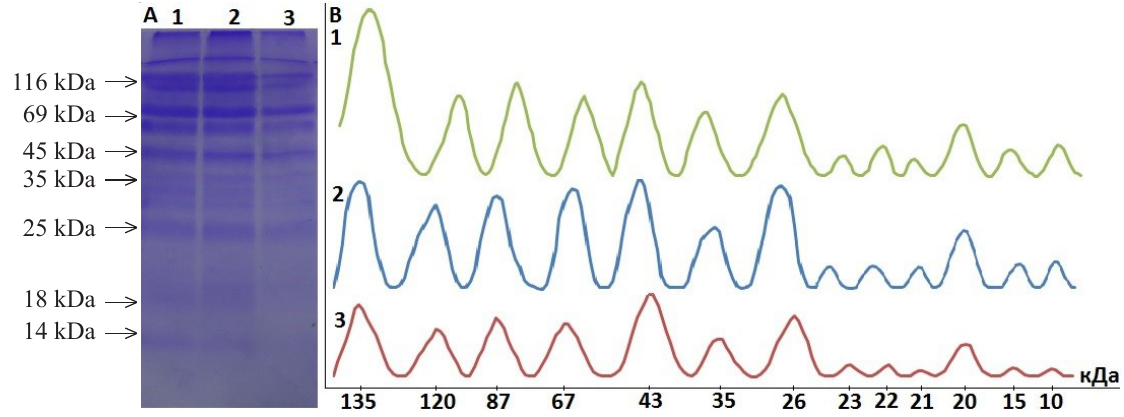
Figure 5 Electrophoregram (A) and MWD profilograms (B) of proteins in the fractions; 1, 2, and 3 – fraction numbers. Fraction No. 4 is not represented as it appeared to have no proteins in its composition Table 2 Yield of water-soluble substances according to the processing conditions Extraction from Extraction from the product Product after mechanical Product after mechanical the initial raw of mechanical activation activation (without activation with 1% of enzyme material without enzymes enzymes) and hydrolysis preparation after hydrolysis Yield of water-soluble 18.0 18.5 60.6 substances, %